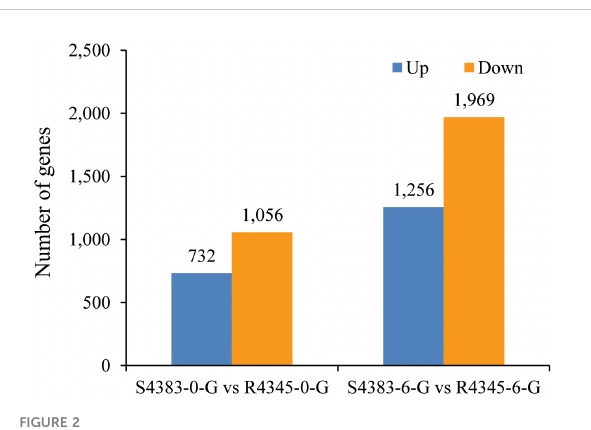
FIGURE 1 Copy number of PirA Vp for gills from VP AHPND -infected shrimp of S4383 and R4345 families. Data are represented as mean ± S.D. (n = 3). Signi fi cant differences between S4383 and R4345 at the same sampling point are indicated with two asterisks at P < 0.01.